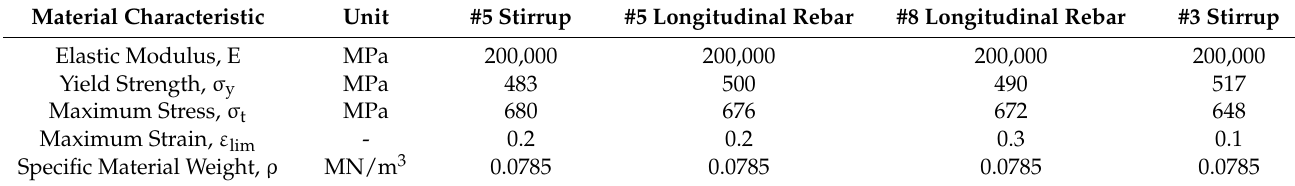
Table 6. Parameters of the reinforcement